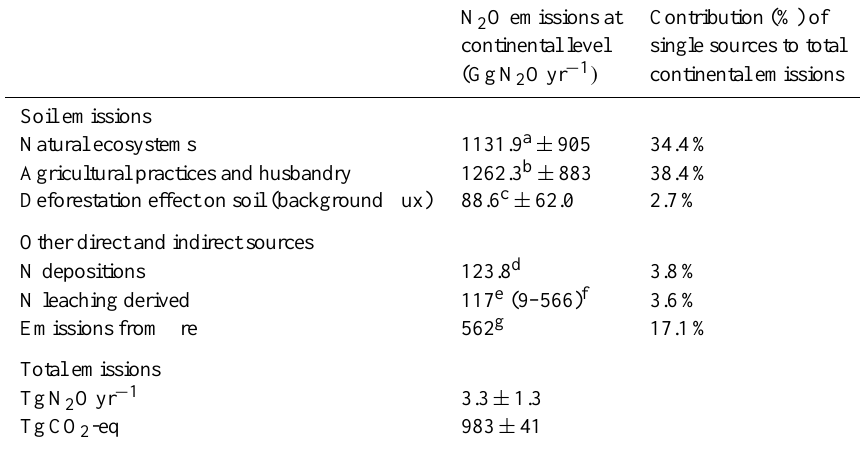
Table 9. Emissions of N 2 O associated to biogenic sources and fires in the African